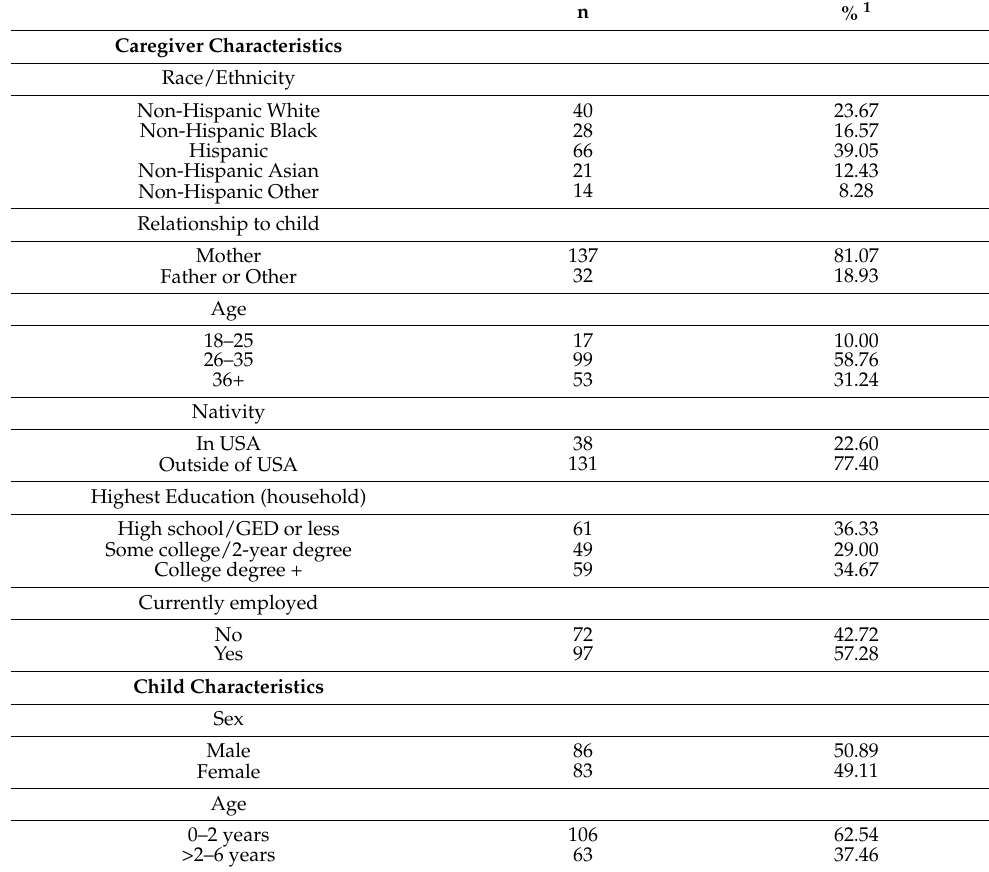
Table 3. Caregiver and child demographic characteristics ( n = 169 caregivers and 169 children) 1